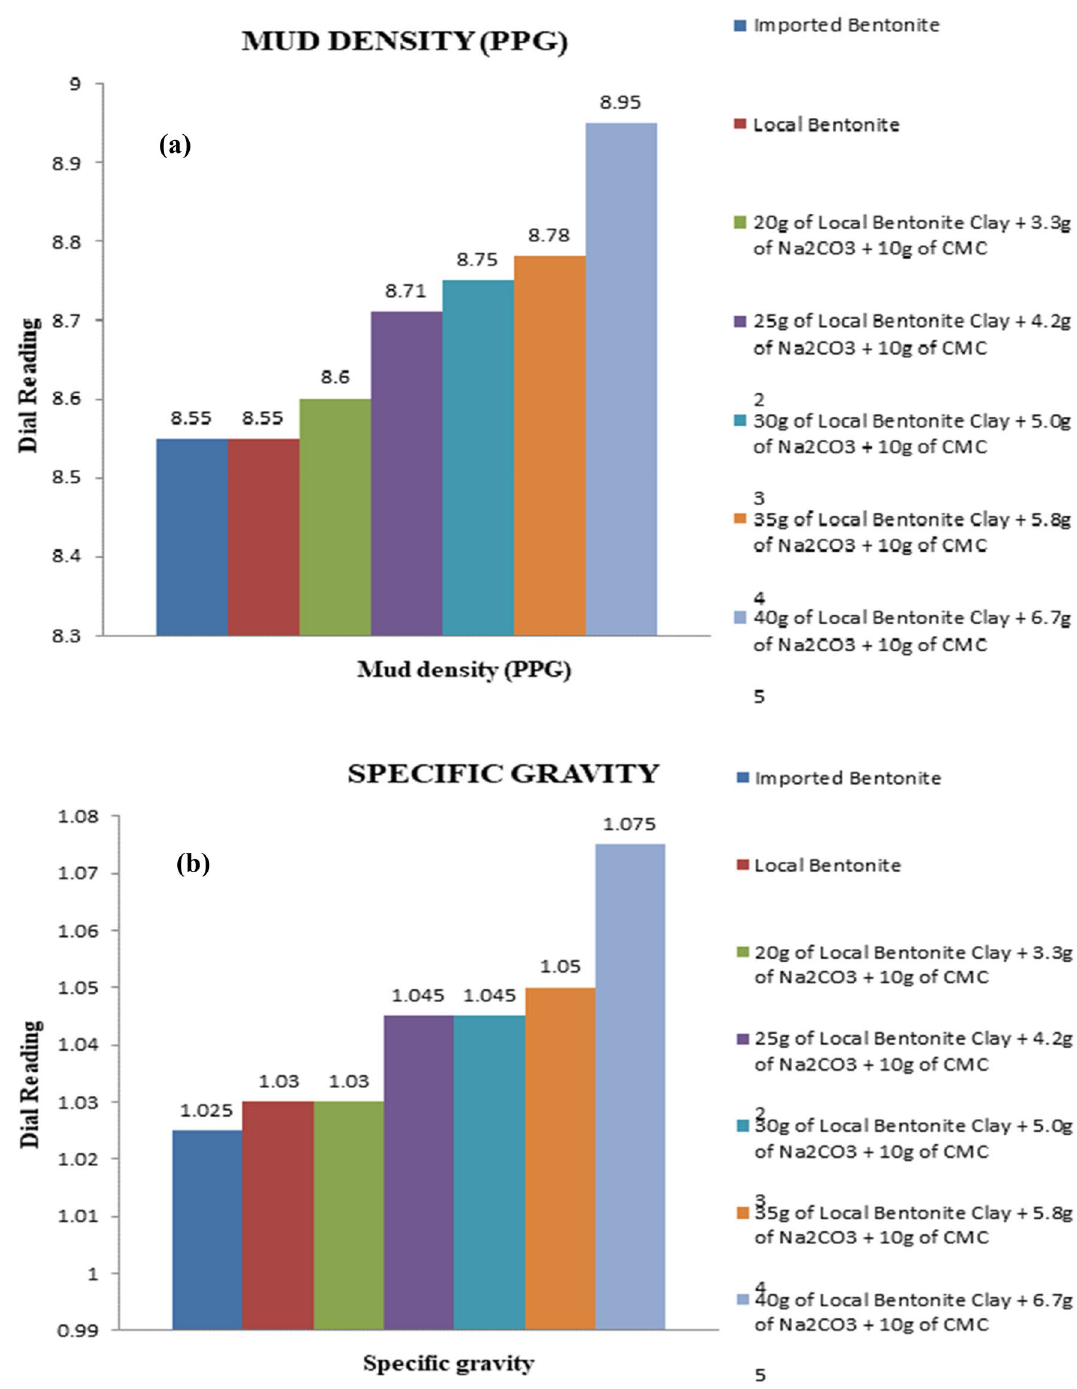
Fig. 8 Histogram showing Mud density ( a ) and specific gravity ( b ) of